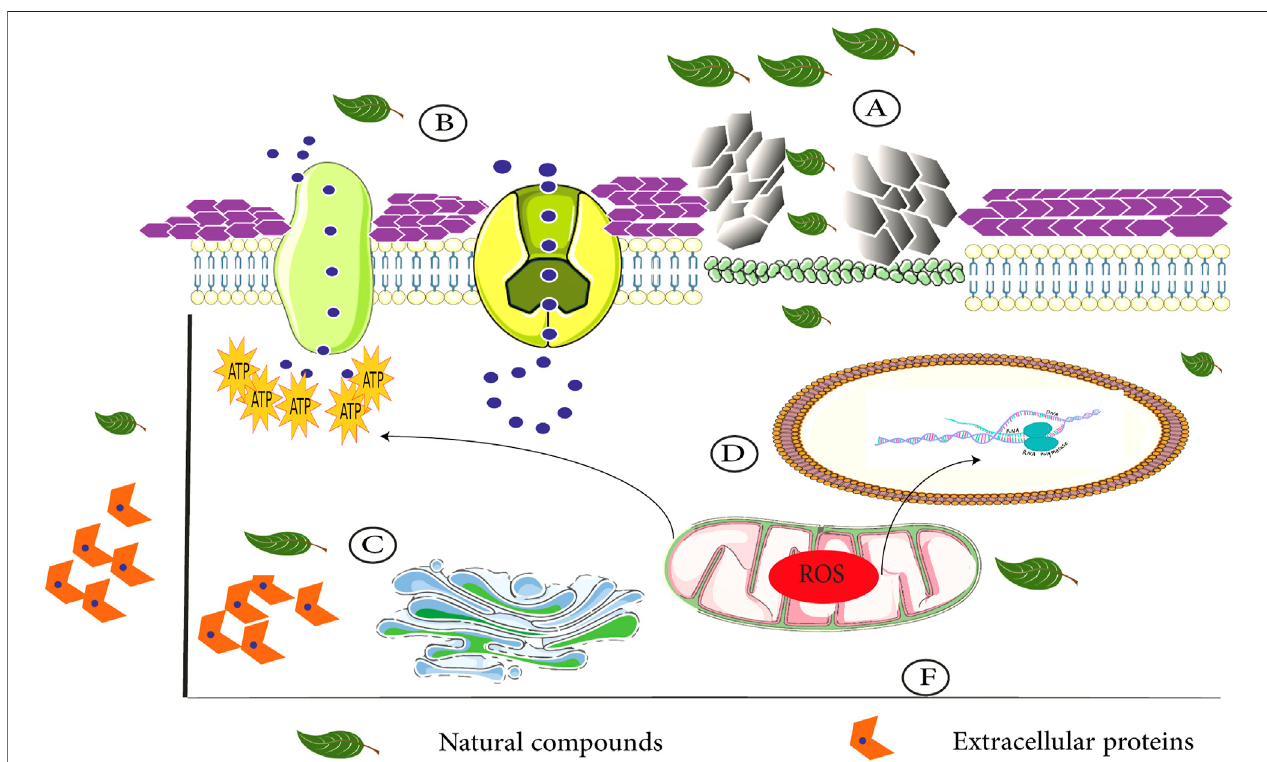
FIGURE 2 | Different interactions of natural compounds with Candida cellular pathways. (A) Ergosterol biosynthesis inhibition (cytoplasm membrane disruption) and cell wall degradation. (B) Negative effects on various Candida cellular pathways such as ABC drug transport: additionally, modulated ef fl ux pump activity. (C) BlockageofproteinaseandphospholipaseactivityandintracellularATPaseproduction. (D) Downregulationoftheexpressionofvariousadhesionandbio fi lm-associated genes. (F) Natural compounds lead to mitochondrial